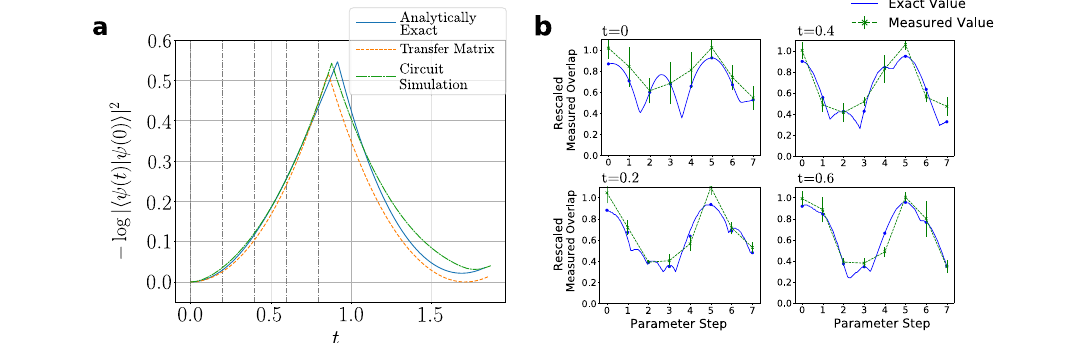
Rainbow: The cost function evaluated along a linear interpolation in the eight parameters from U and extending through the exact update is shown for each of the indicated time-steps in ( a ). The cost-function is rescaled by a Loschmidt echo obtained by overlapping the left hand of the circuit in ( a ), including the time- evolution operator, with its Hermitian conjugate. The optimum value of the rescaled circuit coincides with that calculated in a classical simulation without